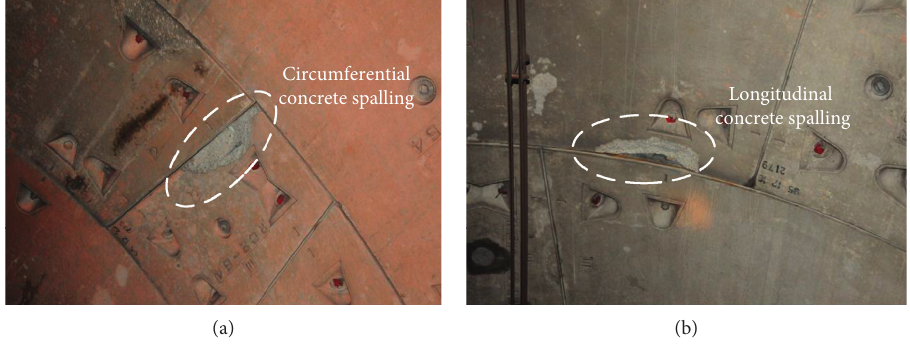
Figure 16: Two types of concrete spalling.